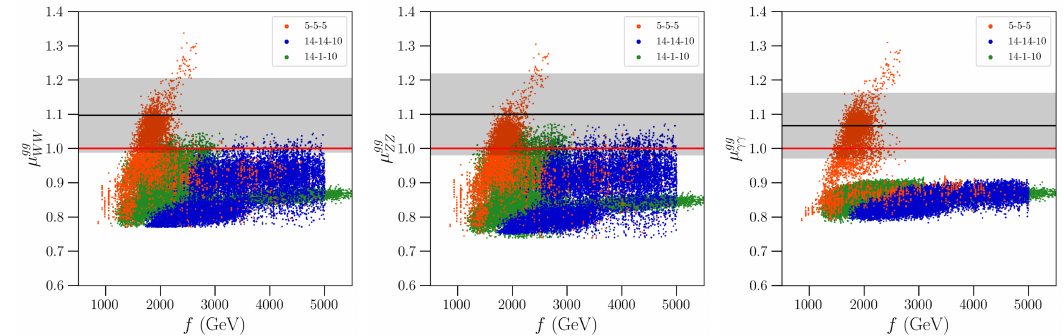
Figure 16. Higgs signal strengths for valid points in the various M4DCHMs. Red lines show the SM predictions µ gg = 1 , while black lines mark the best-fit values, and the shaded regions the 1 σ XX uncertainties, of the combined measurements of these